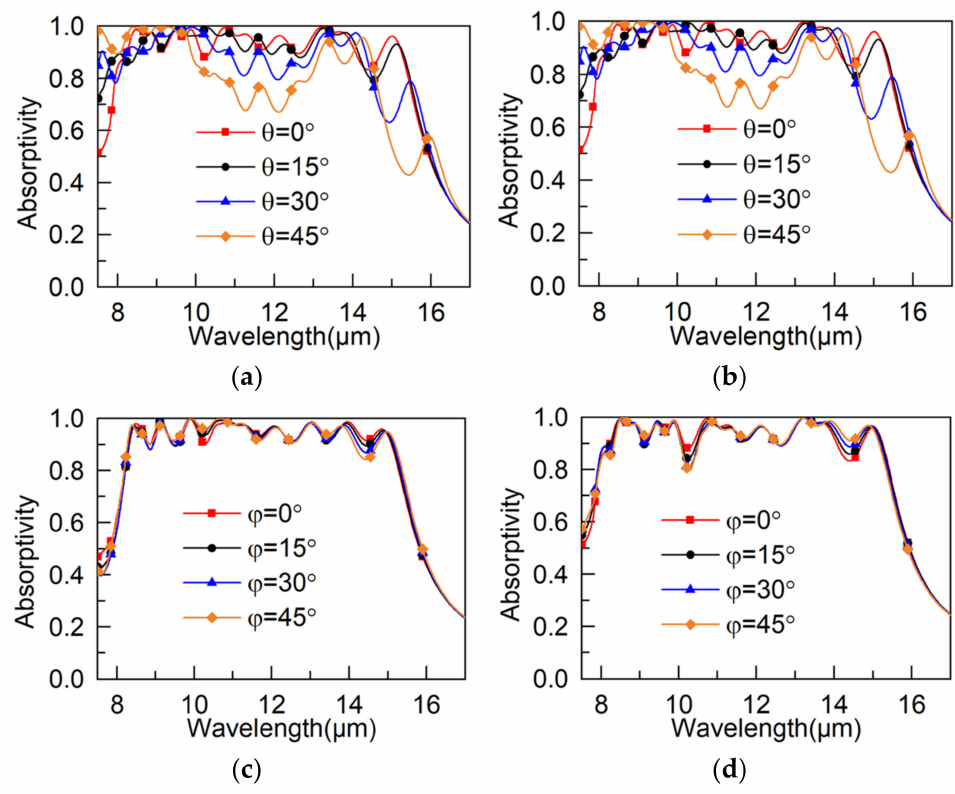
Figure 3. Absorptivity with ( a ) oblique incident of TE wave, ( b ) oblique incident of TM wave, ( c ) different polarization angles of TE wave, and ( d ) different polarization angles of TM